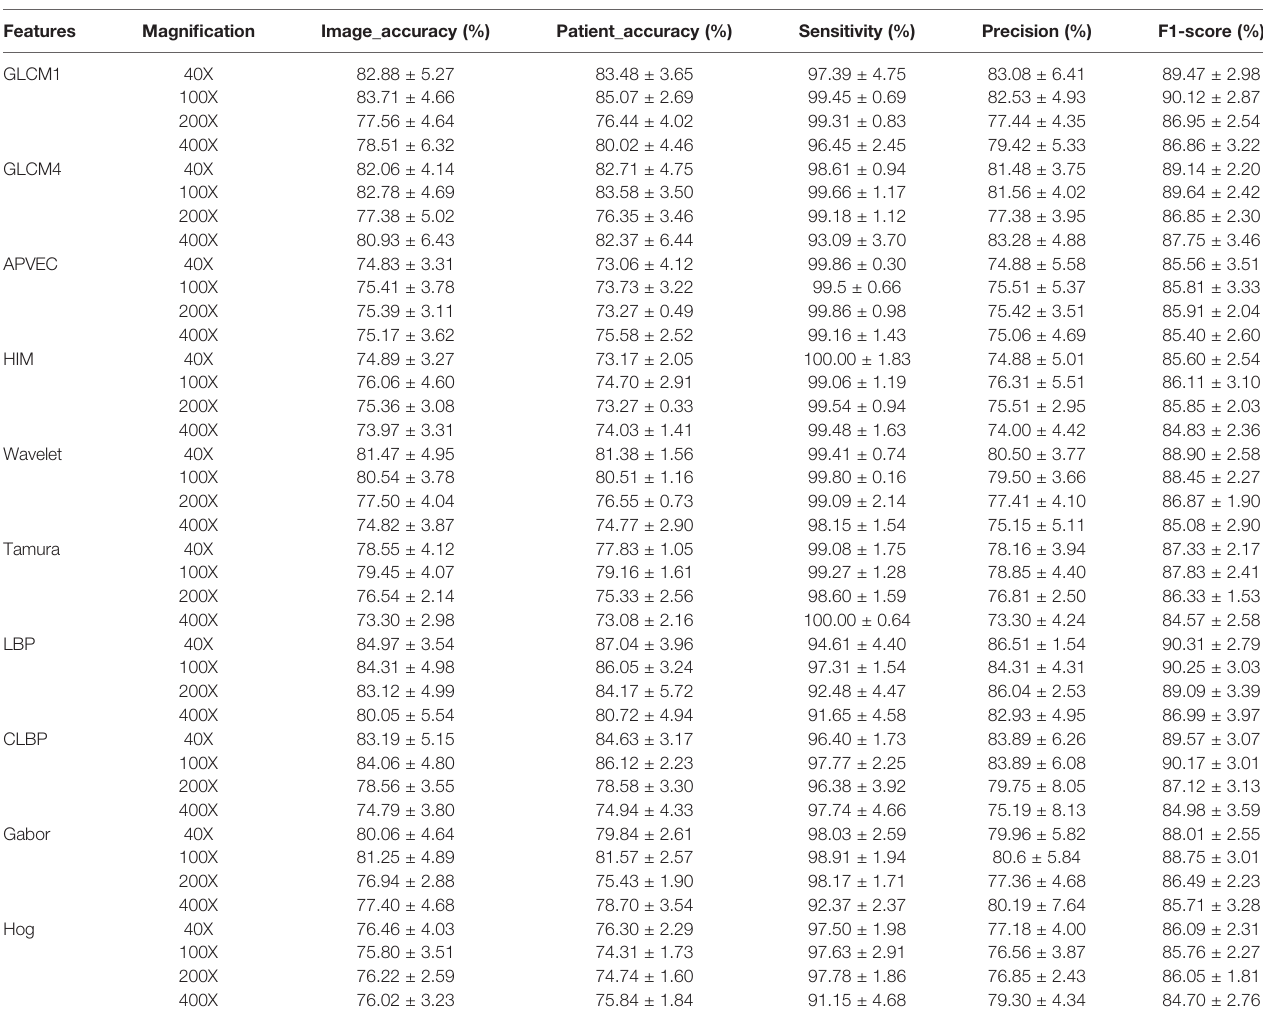
TABLE 5 | Classi fi cation performance of different gray-level features.